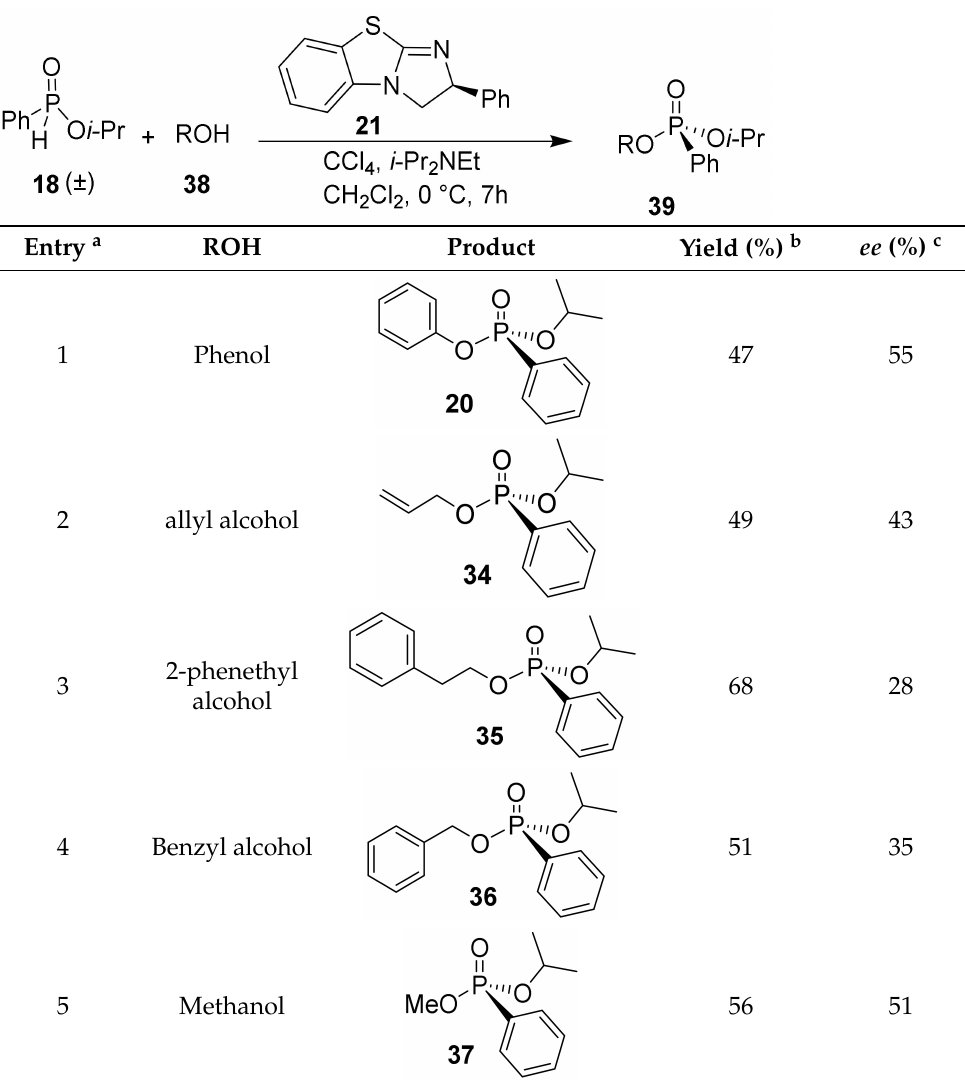
Table 4. Effects of the nucleophile on the phosphorylation